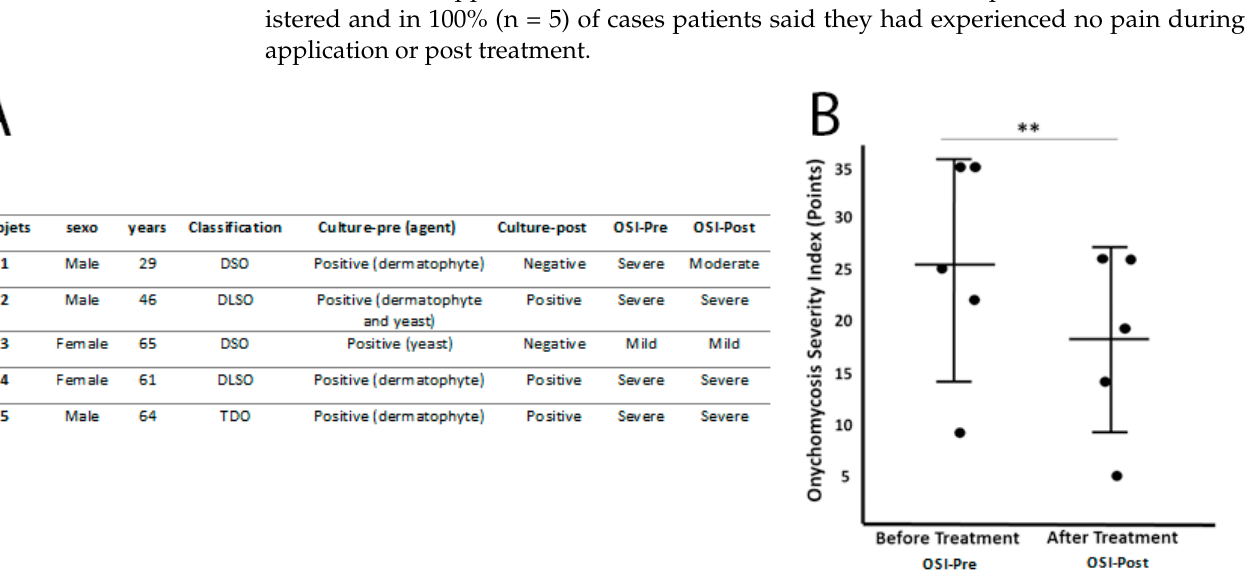
Figure 2. Detailed results by participants ( A ) and representation of evolution based on the points OSI ( B ). ** p-value = 0.011.